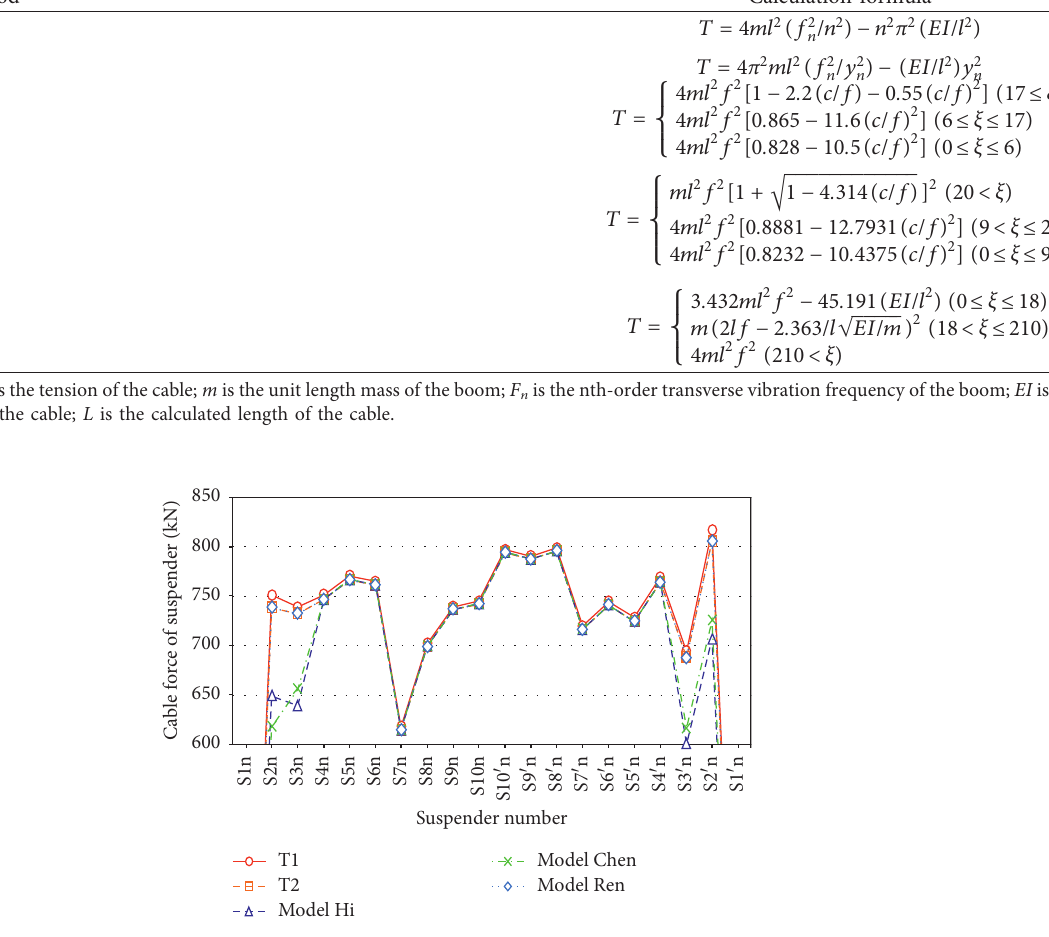
Figure 21: Calculated values of cable force by different